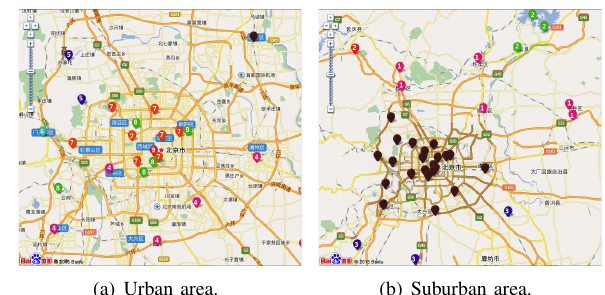
Fig. 4. Distributions of the observation stations. Map provide by Baidu.com, Inc.